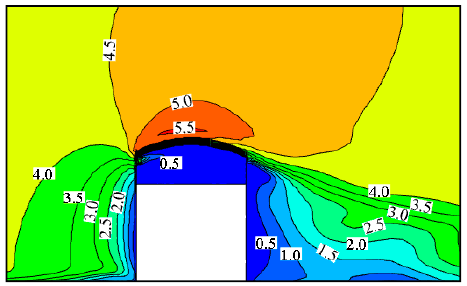
Figure 10. Velocity distribution of the IFRT under the ambient wind speed of 4.36 m·s − 1 .